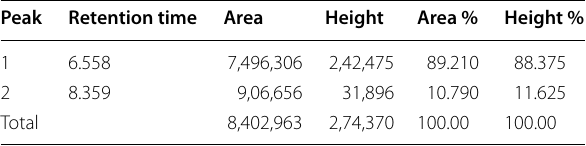
Table 4 HPLC data of ( RS )-α-methyl benzyl amine after catalysed by ( R )-specific transaminase Peak Retention time